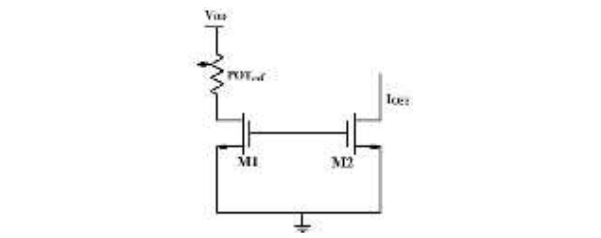
Figure 3. Simplest tunable current source for